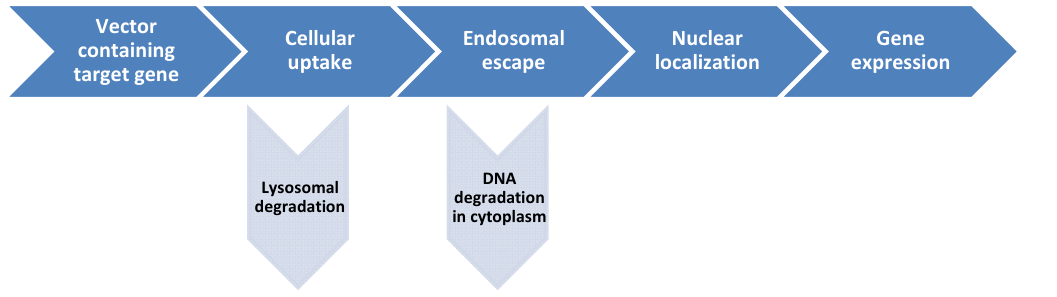
Scheme 1. Intracellular trafficking of DNA-delivery vector complexes.